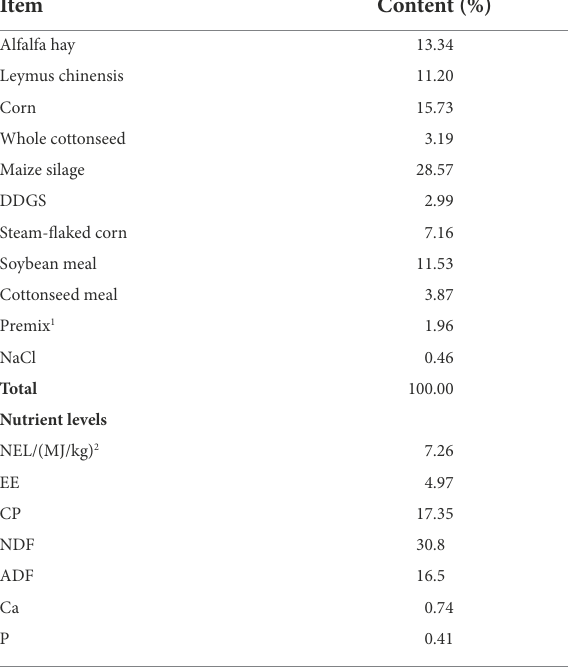
TABLE 1 Components and nutritional analysis of the total mixed rations (dry matter basis, n =